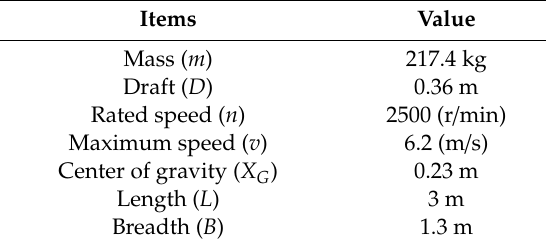
Table 2. Particulars of the USV.